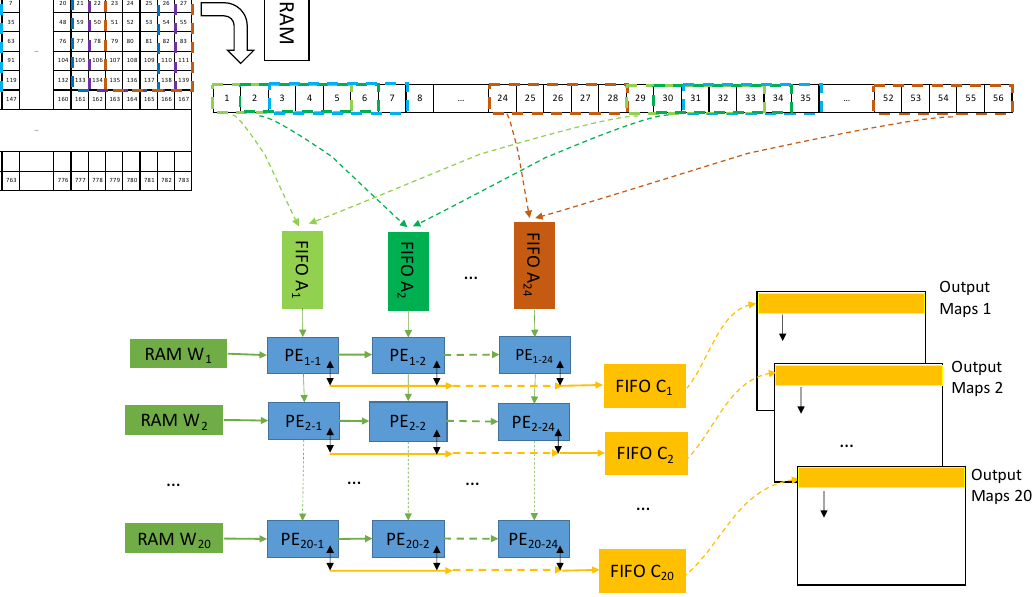
Figure 12. The first layer of the convolution computing structure. According to the number and size of convolution kernels in the first layer, we construct a 20 × 24 systolic array. Our structure generally consists of a set of PE arrays for convolution operations, FIFO A for buffering input feature maps, RAM W for storing weights, and FIFO C for storing output feature